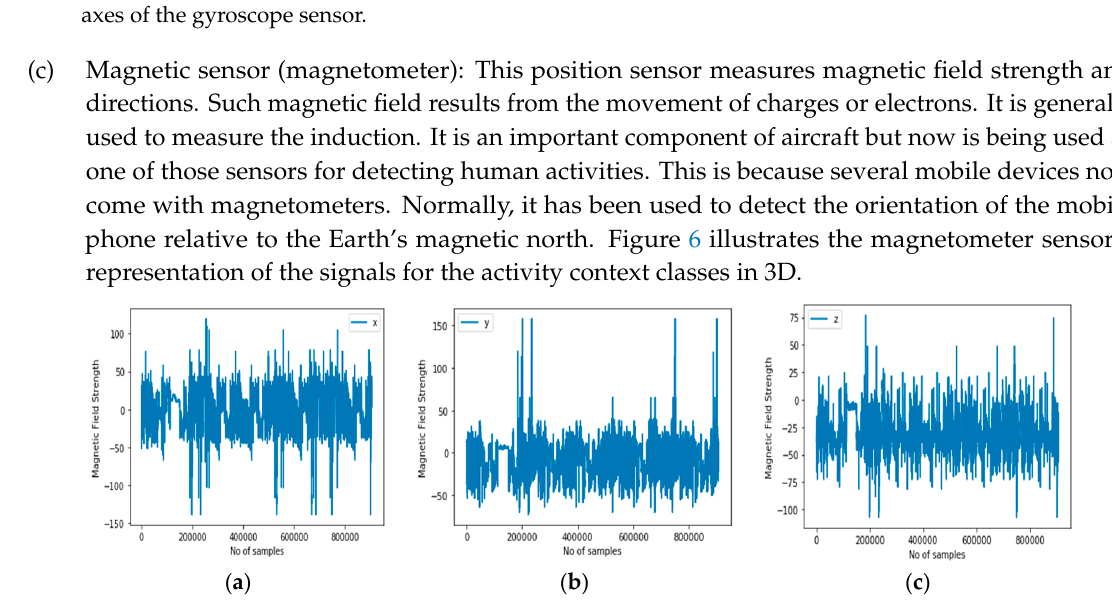
Figure 6. 3-D magnetometer signals representing all activity contexts . ( a ), ( b ), and ( c ) respectively are the x, y, and z axes of the magnetometer sensor.